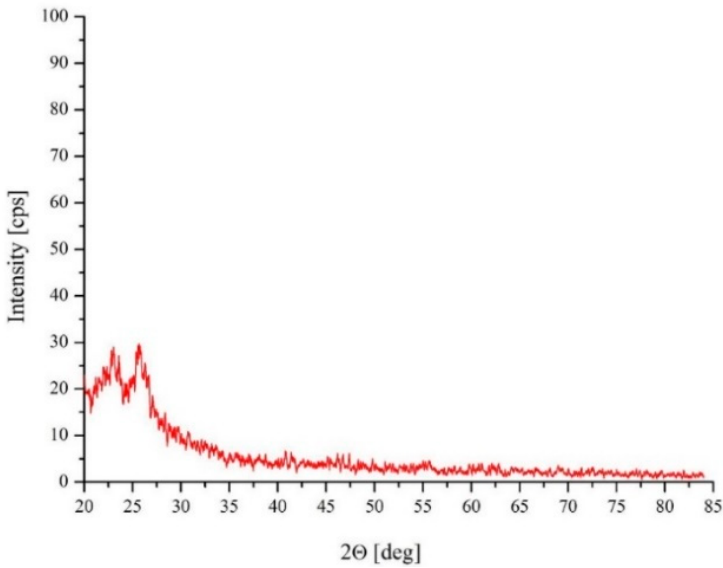
Figure 9. The X-ray diffractometer (XRD) spectra of the isochronally annealed samples.